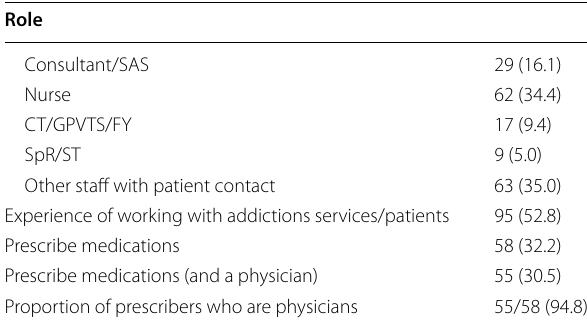
Table 2 Staff profile of CBD survey responders ( n represent frequencies (percentages)